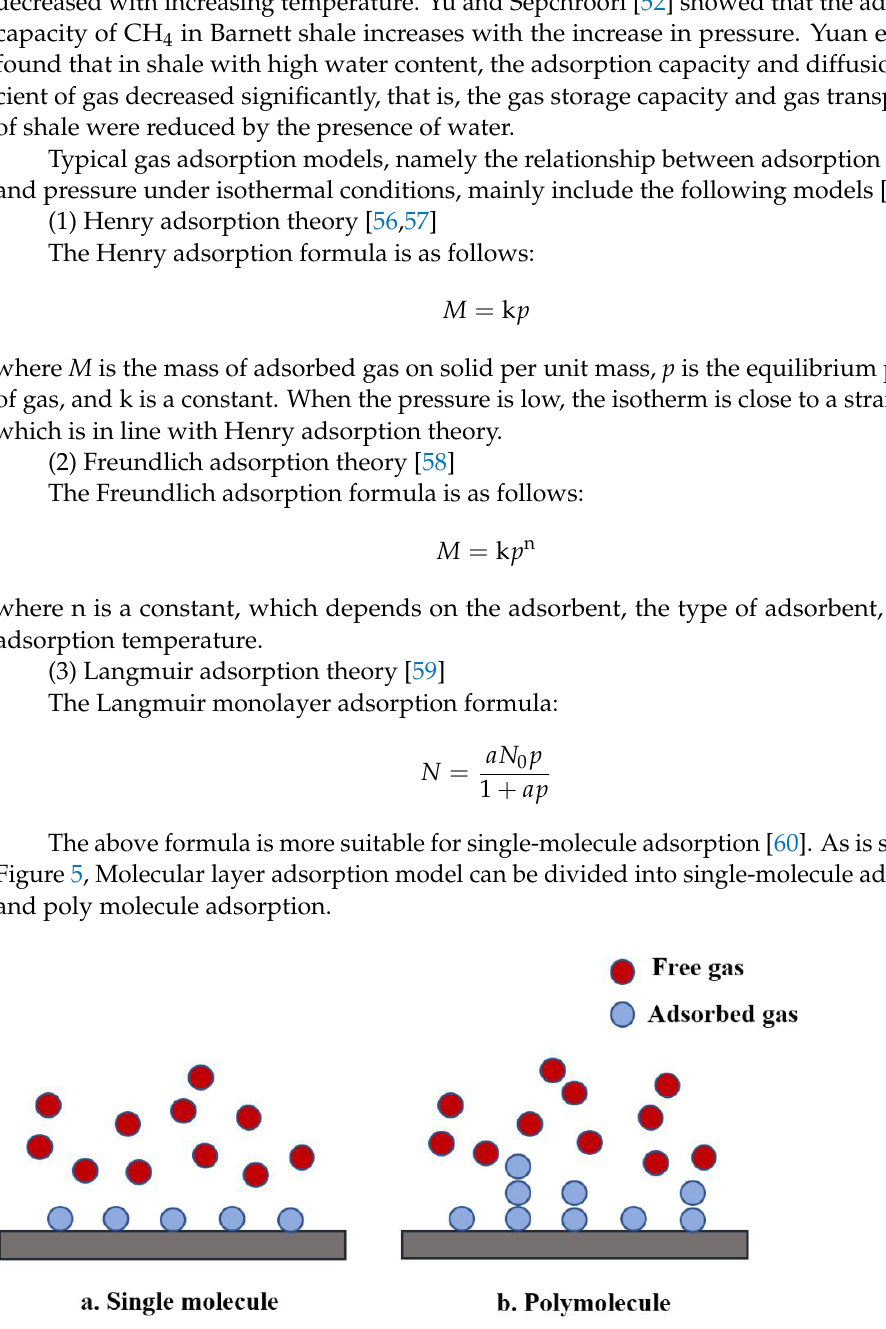
Figure 5. Molecular layer adsorption model (modified from [54]).